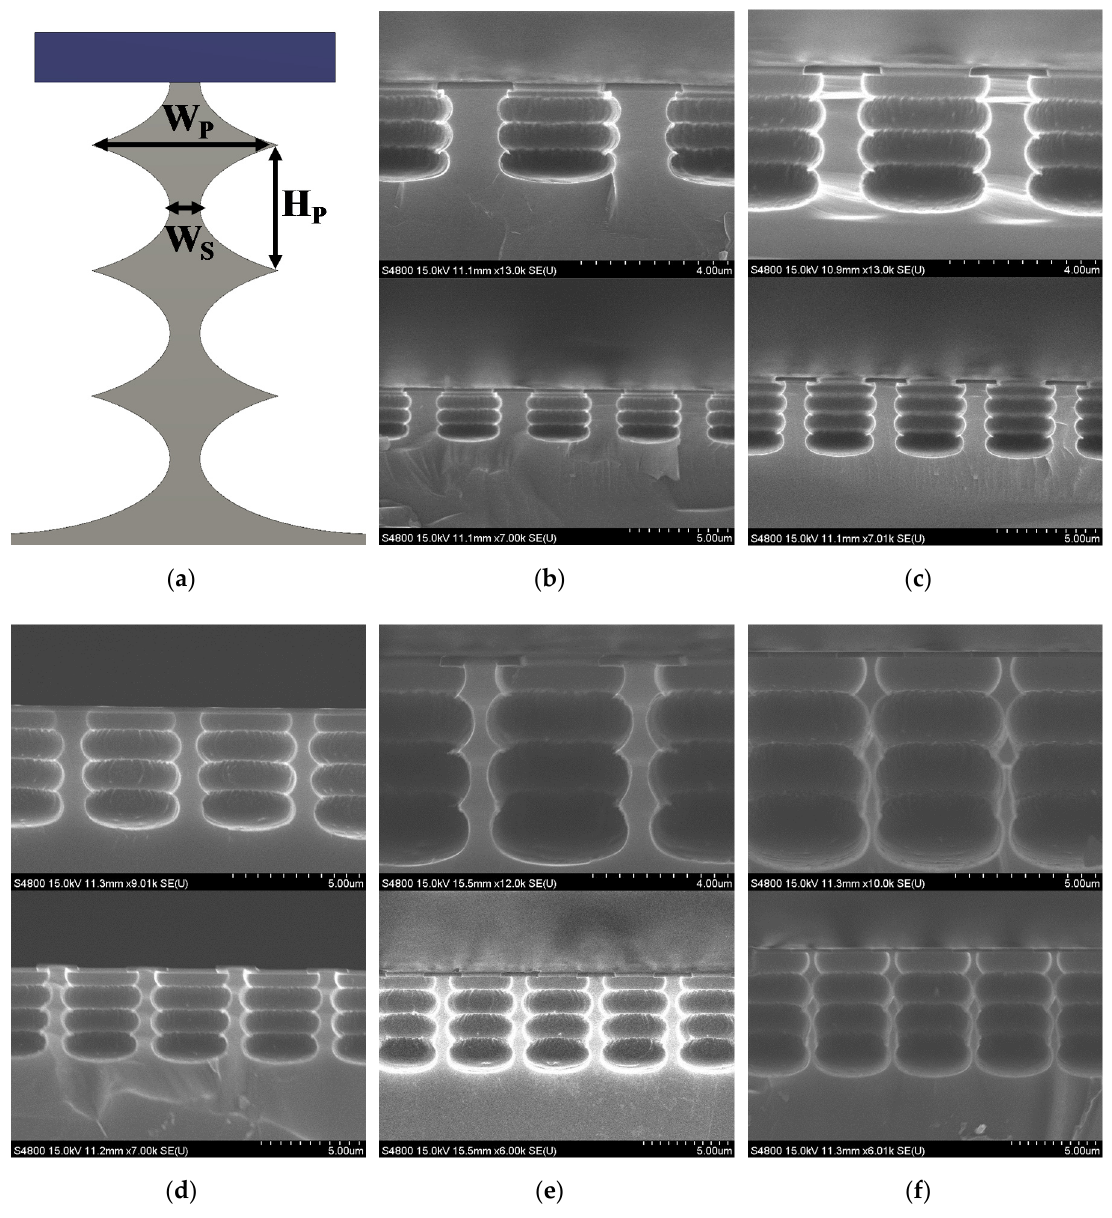
Figure 4. Experimental results of the DRIE process with various isotropic-silicon etching times. ( a ) Dimension parameters; ( b ) 5 s (typical Bosch process case); ( c ) 7 s; ( d ) 10 s; ( e ) 15 s; ( f ) 18 s. Table 2. Measurement results after various time duration during the DRIE